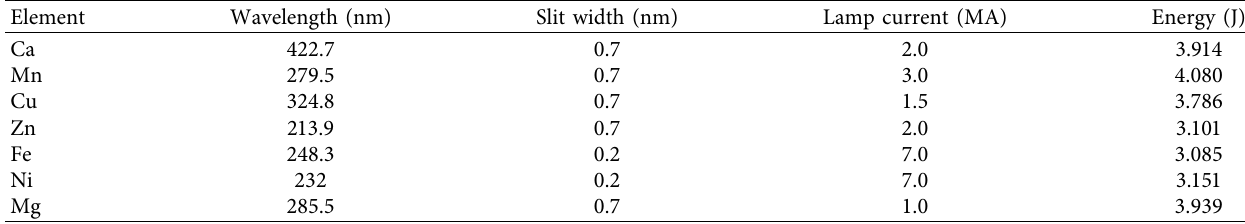
Table 1: Instrument operating conditions used for the determination of metallic elements using fame atomic absorption spectroscopy. Element